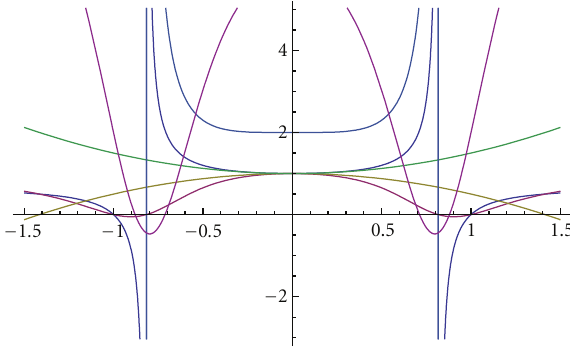
Figure 3: Plot of the six conditions Q i and c i derived previously, as a function x . Here γ = − 1. Allowed values for the field velocity are typically | x | < O ( | γ | − 1 / 2